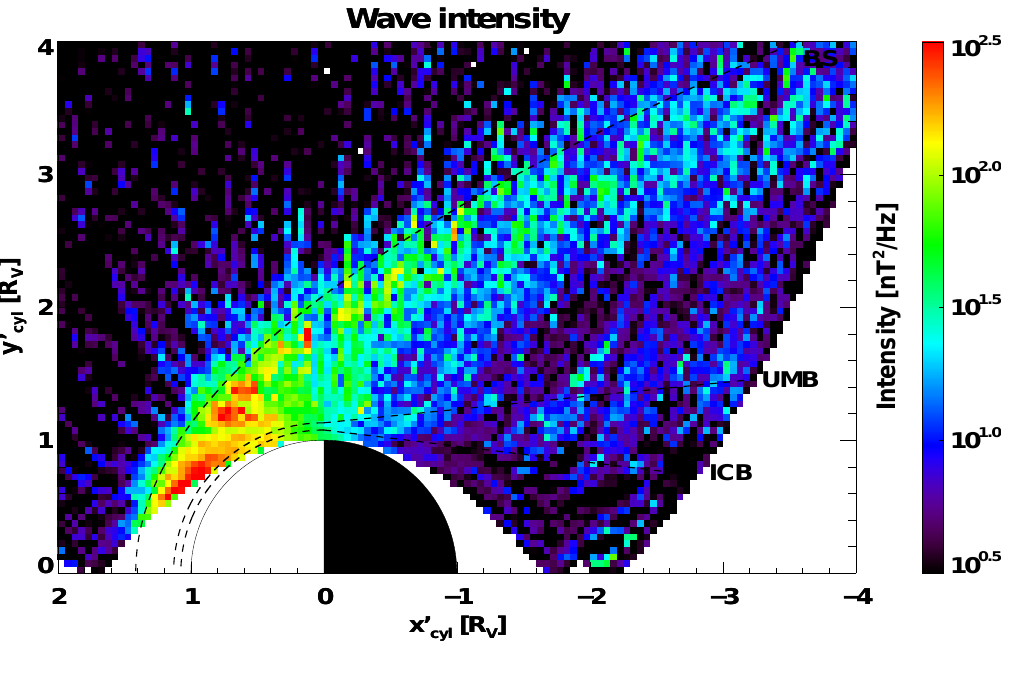
Fig. 8. Spatial distribution of the wave intensity. The intensity is enhanced in the entire dayside magnetosheath and drops rapidly towards the terminator. In the nightside magnetosheath the intensity has a reduced level. No significant intensity occurs in the upstream solar wind and the mantle and tail region.